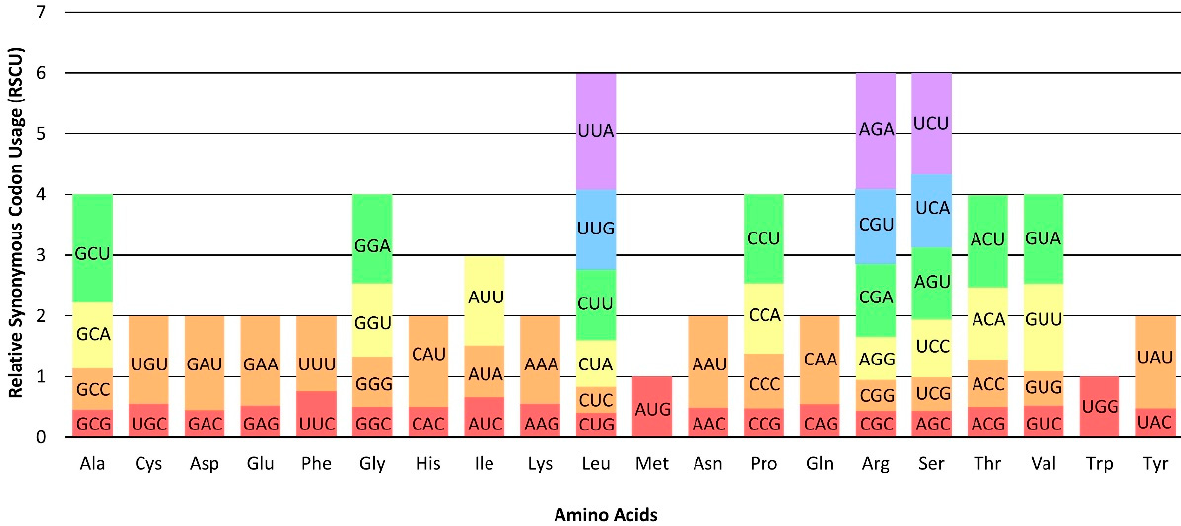
Figure 5. Codon usage in the fourteen Smilacaceae species.